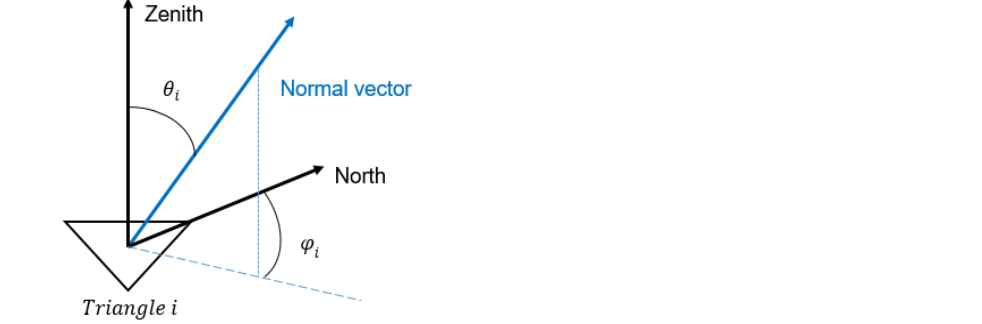
Figure 3. Computation of LAD (leaf angle distribution) based on normal vector of each triangle.